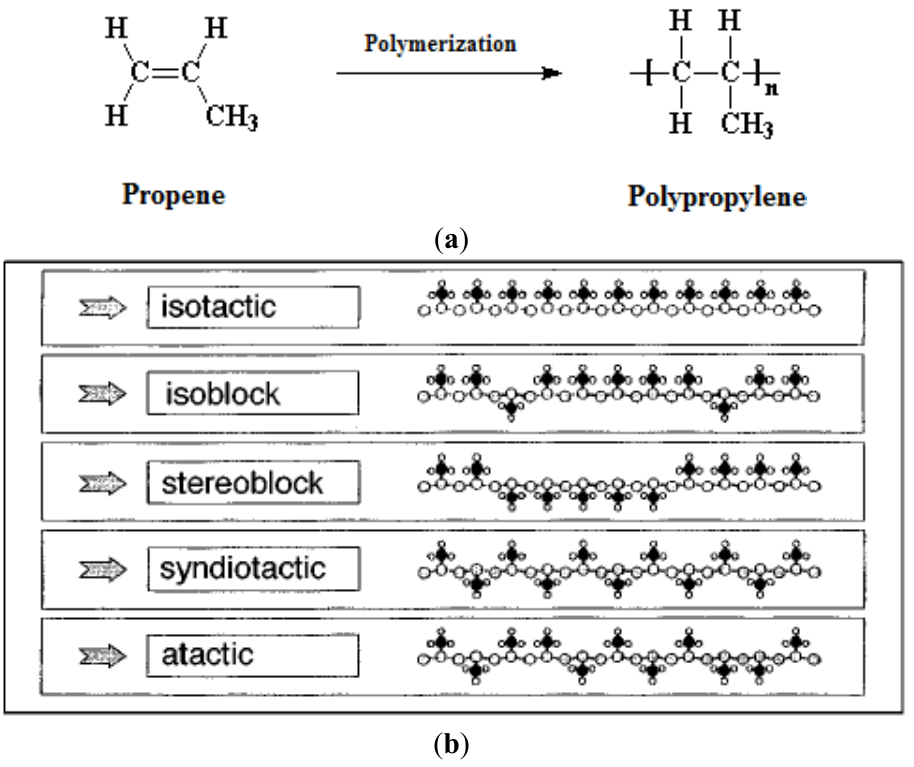
Figure 7. ( a ) Two-dimensional representation of linear PP that results from the arrangement of monomer units along the polymer chain during the polymerization process; and ( b ) portions of linear PP with different orientations of pendant methyl groups along the polymer backbone, reprinted with permissions from [58]. Copyright 2011